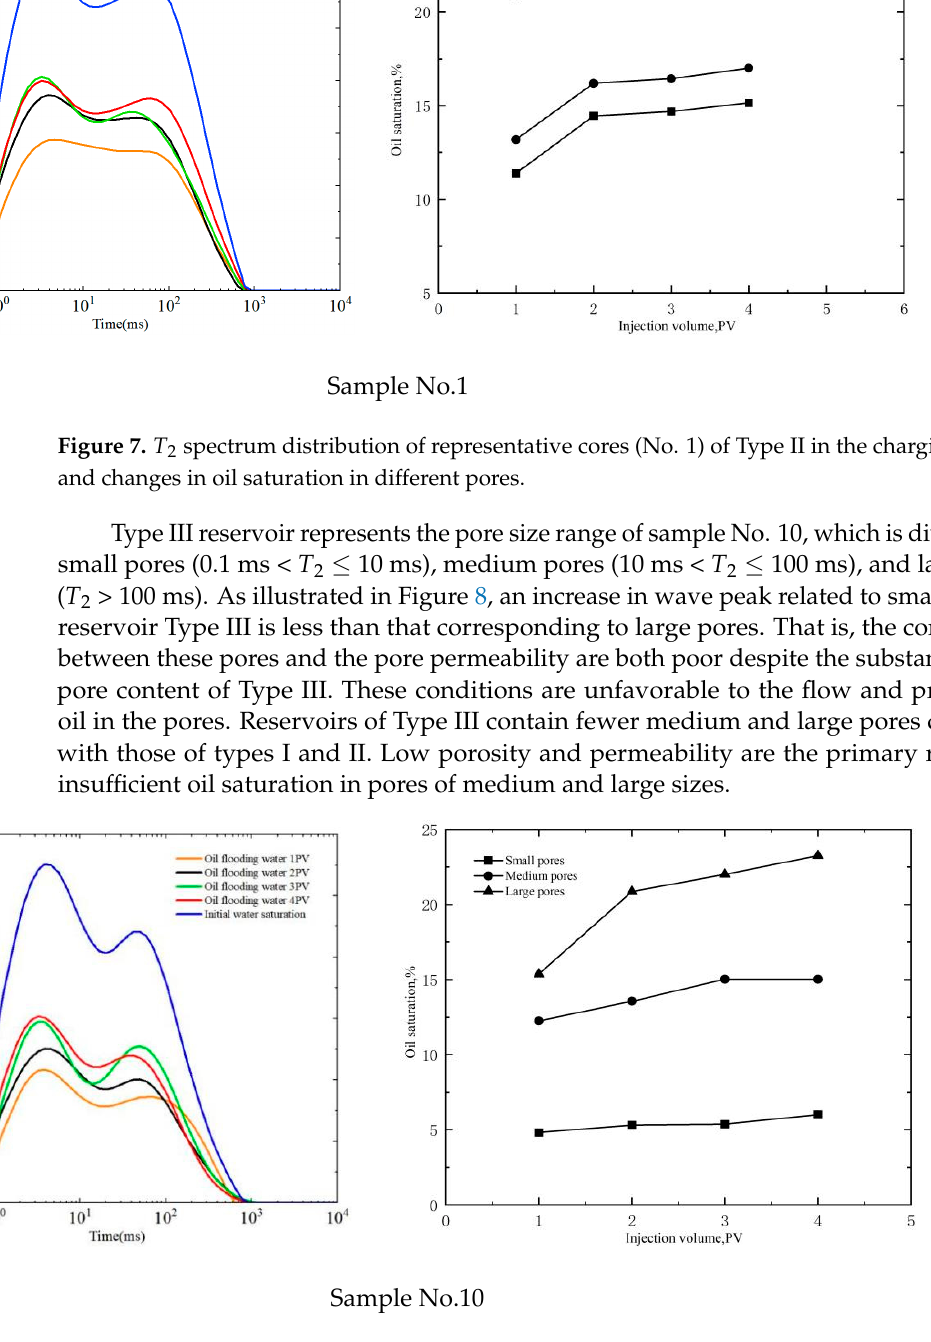
Figure 6. T 2 spectrum distribution of representative cores (Nos. 6 and 8) of Type I in the charging process and changes in oil saturation in different pores.